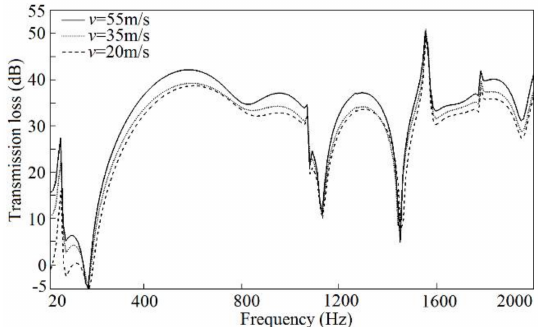
Figure 17. Effects of flow velocity on the TL of the silencer ( T = 760